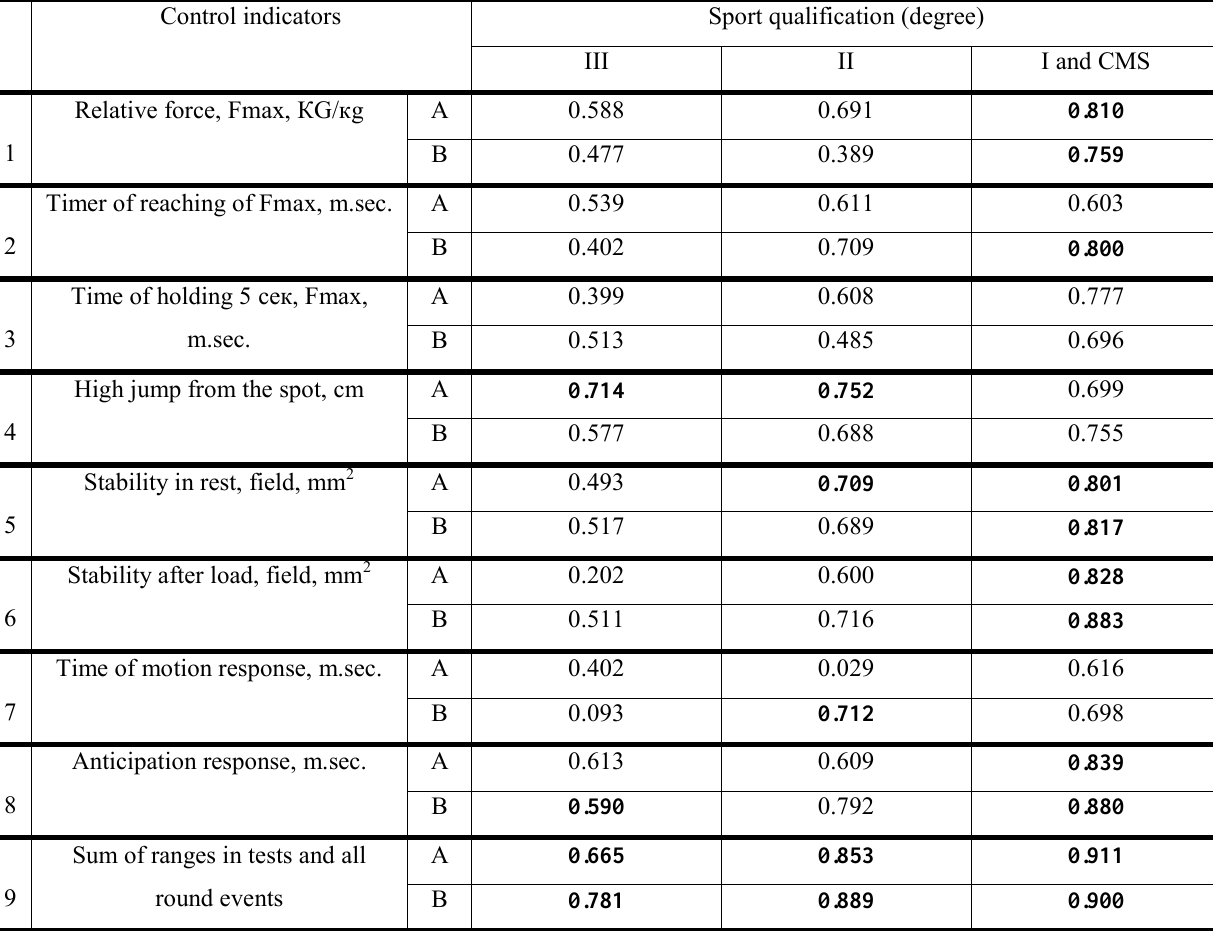
Informative character of indicators of female gymnasts (А)and gymnasts (B) as value of ranges’ correlation in tests and in sum of all round events Control